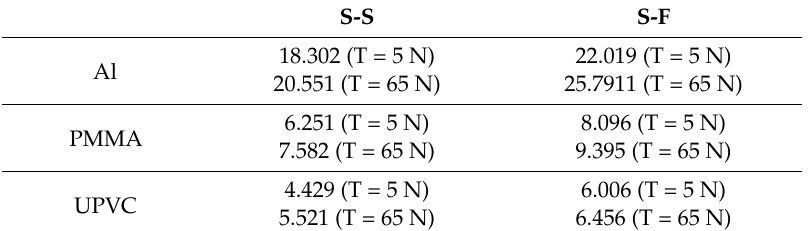
Table 4. The natural vibration frequencies for different risers with different end conditions (Hz).